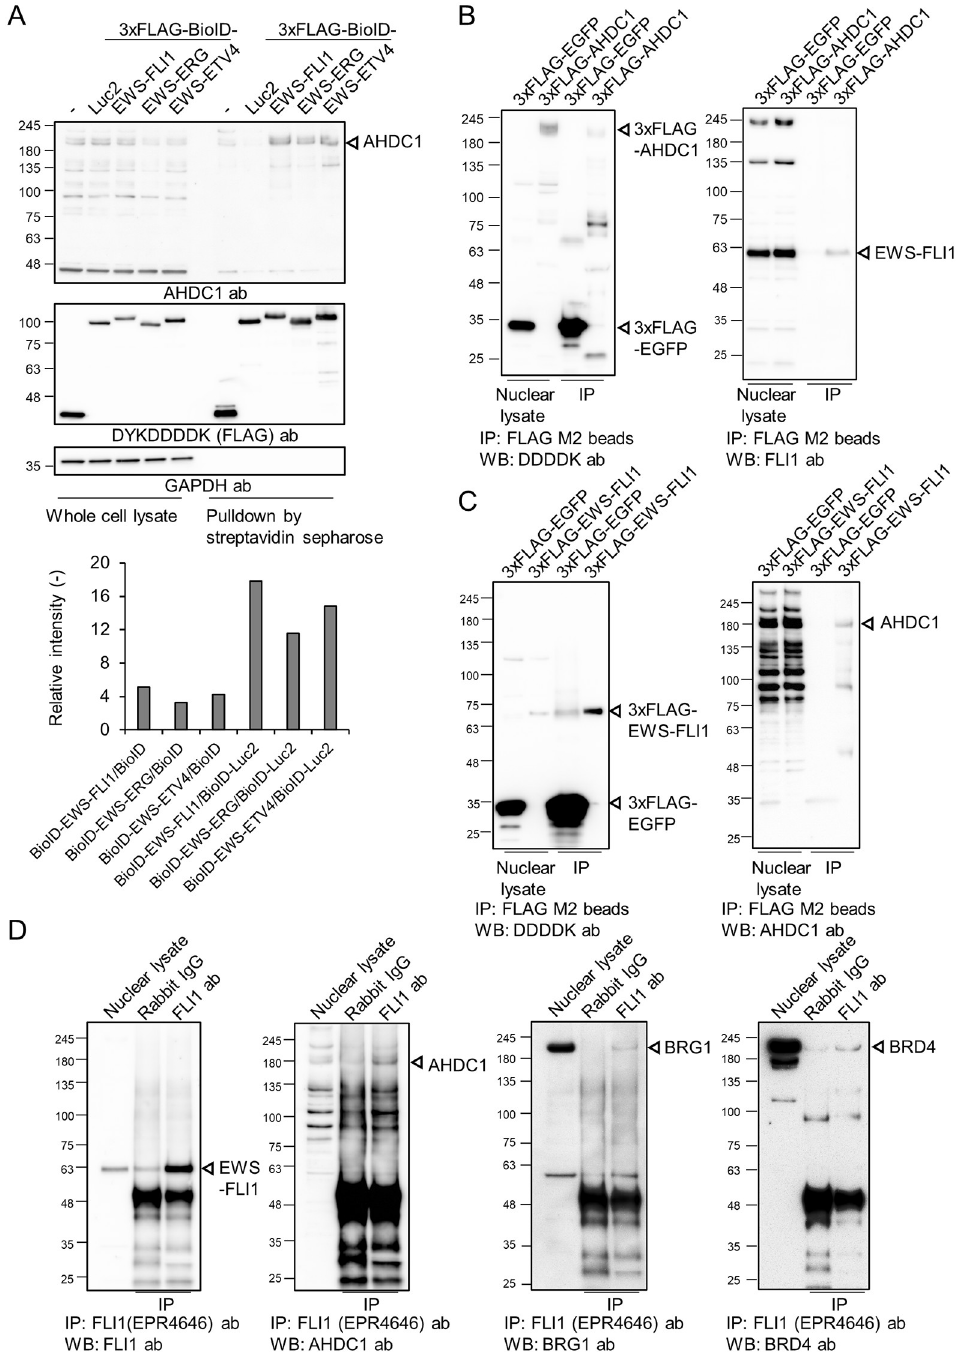
Fig 2. Immunoprecipitation of AHDC1. (A) Western blotting analysis after streptavidin-conjugated sepharose beads. Ten μ g of proteins and one-tenth of pulldown input were used as a whole-cell lysate and a biotinylated protein sample, respectively. Band intensity was compared as a BioID or BioID-tagged Luc2. GAPDH antibody was used as a negative control. (B) Western blotting analysis of co-immunoprecipitated samples. 300 μ g of nuclear lysate was mixed with FLAG M2 magnetic beads for immunoprecipitation. Five μ g of nuclear and one-fifth of the immunoprecipitation input were used for western blotting. (C) Western blotting analysis of co-immunoprecipitated samples. 300 μ g of nuclear lysate was mixed with FLAG M2 magnetic beads for immunoprecipitation. (D) Western blotting analysis of co- immunoprecipitated samples. 500 μ g of nuclear lysate was combined with FLI1 antibody and protein A/G magnetic beads for immunoprecipitation. Five μ g of nuclear lysate and one-fifth of the immunoprecipitation input were used for western blotting.